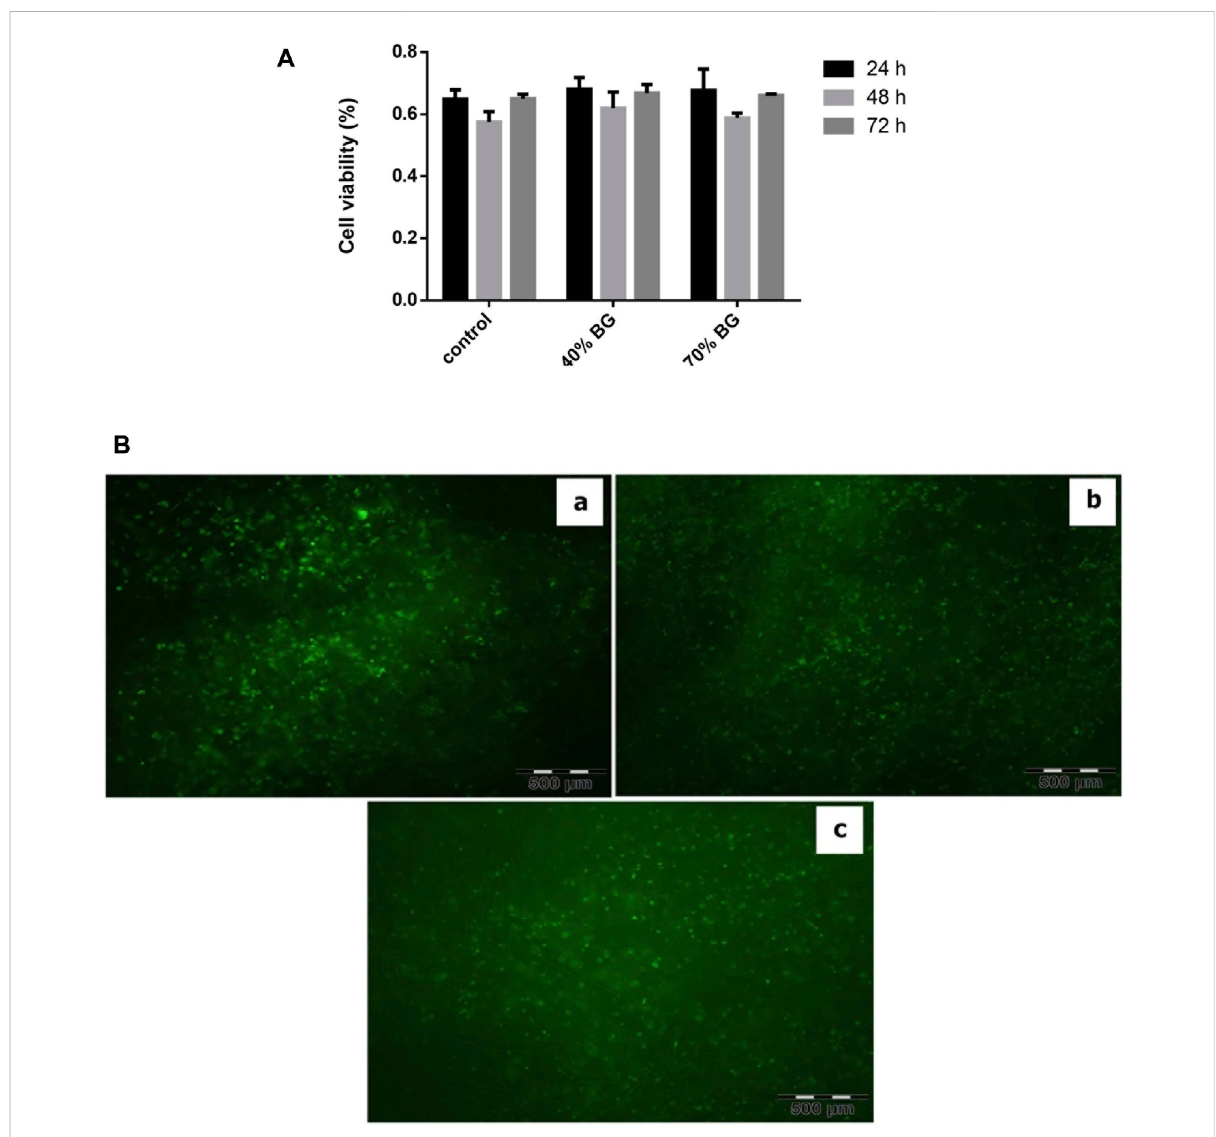
FIGURE 5 Viability assay of BM-MSCs in the sponges using MTT and PI-FDA staining. (A) Cell viability on the BG-collagen/PGA scaffolds. The results were expressed as proliferation of MSCs on scaffolds. Each experiment was repeated independently three times in triplicate tests * p < 0.05; signi fi cant againsttheviabilityofcellsoncollagen/PGAscaffoldwithoutBGincorporation. (B) CellviabilitystainingwithPI/FDA. (a) BG/PGA-collagen0/100, (b) BG/PGA-collagen40/60, (c) BG/PGA-collagen70/30 w/w.Thestainingpresentswithviablecellsandhomogeneouscelldistributionwithinthe scaffold (Magni fi cation10X).BGcontainingscaffolds arebiocompatibleasevidenced bycellattachment, spreadingandmaintenanceofcellviability within the